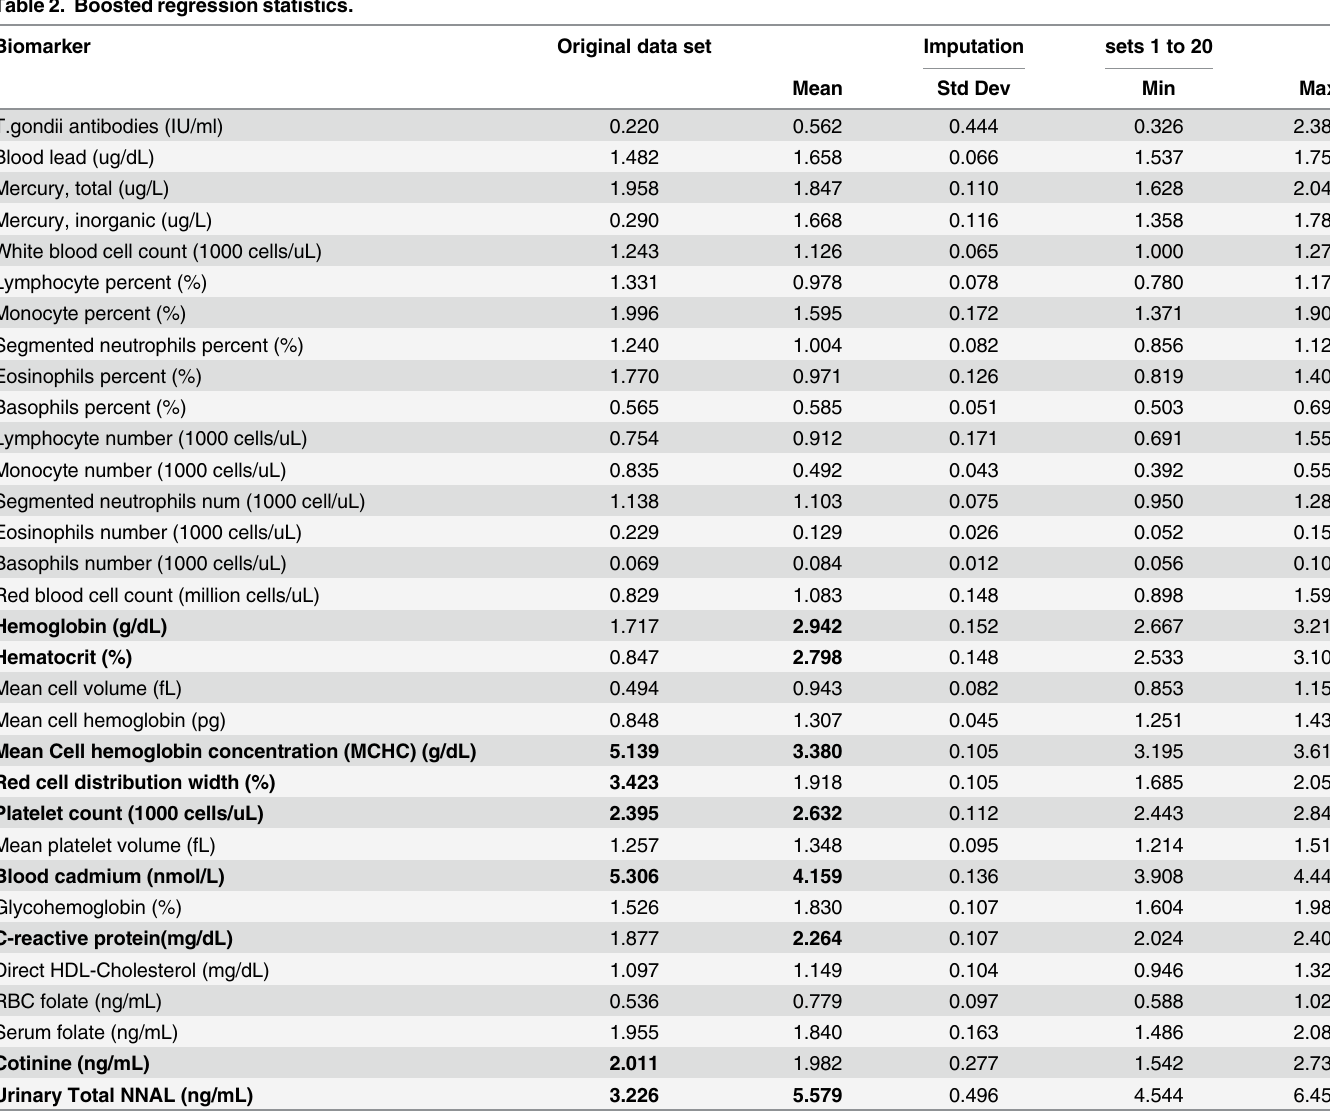
Table 2. Boosted regression